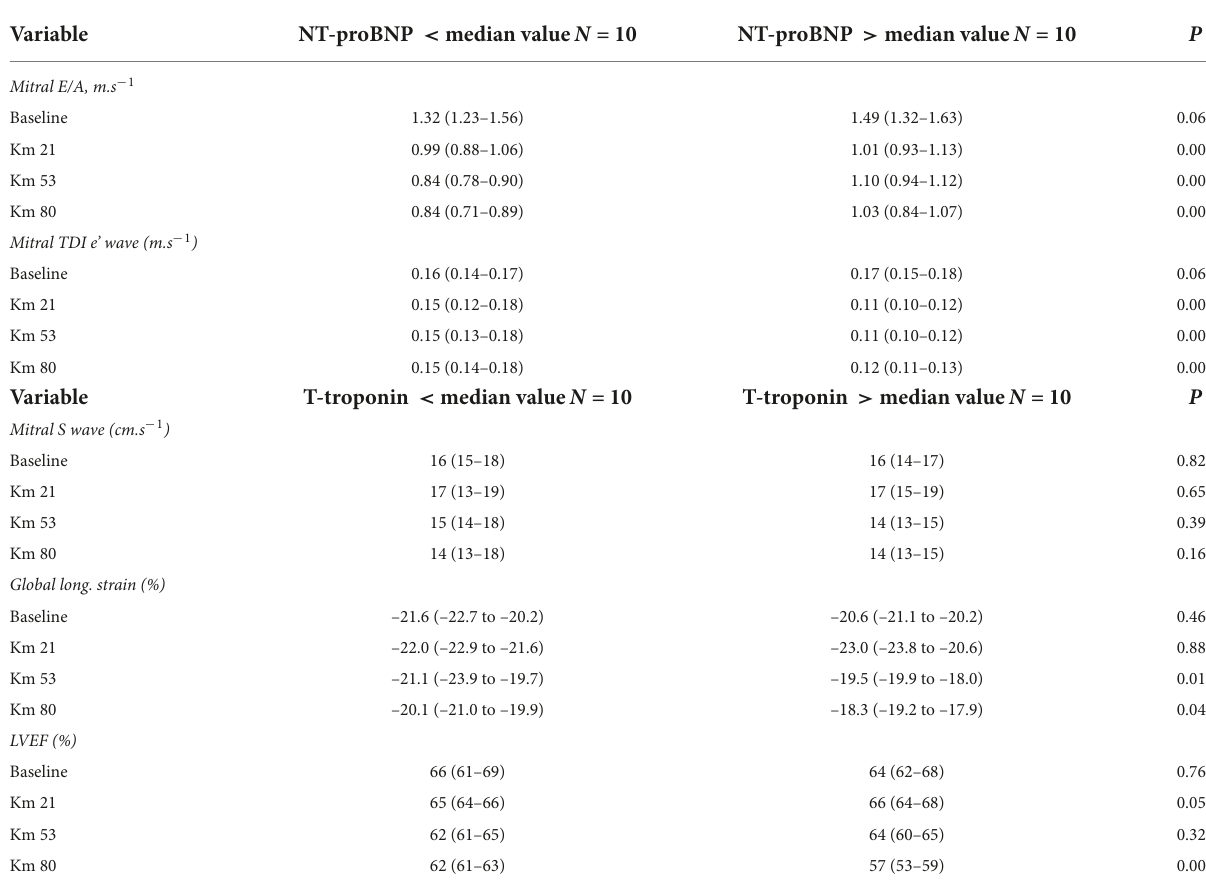
TABLE 4 Relationship between echocardiographic parameters and cardiac